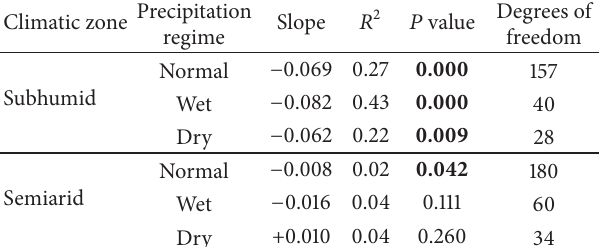
Table 3: Summary of the relationships between the annual sum- merfallow area (% of total ecodistrict area) and the seasonal average of range of dew point temperatures ( ∘ C) from the early morning minimum to the late morning maximum from 1961 to 2006. Bold faced 𝑃 values show the significant relationships, at the 0.05 level of